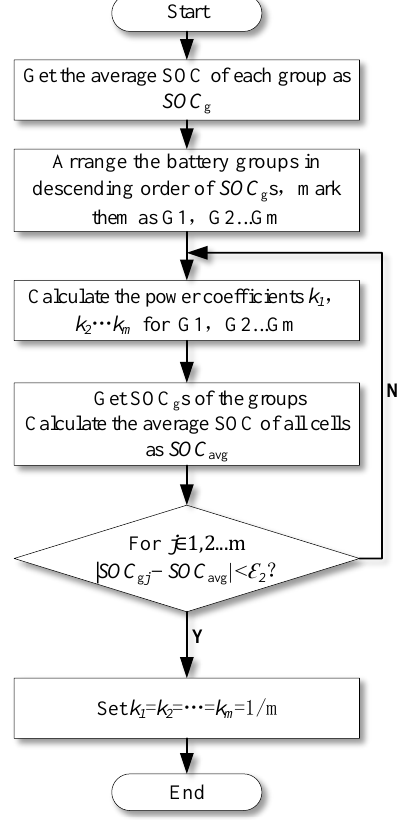
Figure 7. Control strategy of the proposed outer layer.